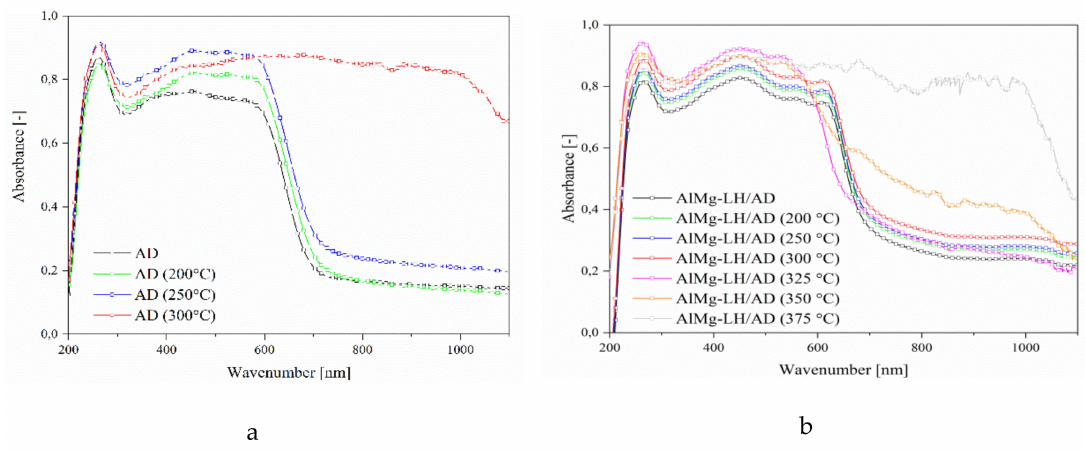
Figure 12. UV–VIS spectra of azo dye and hybrid pigment exposed to different temperatures: ( a ) AD; and ( b ) AlMg − LH/AD